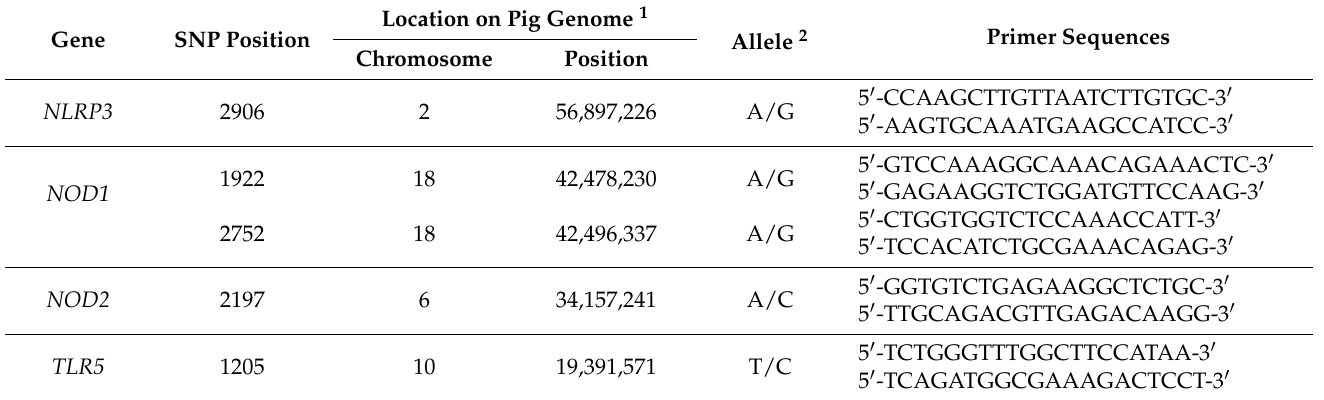
Table 2. Genotyped SNPs in PRR genes and primer was used.